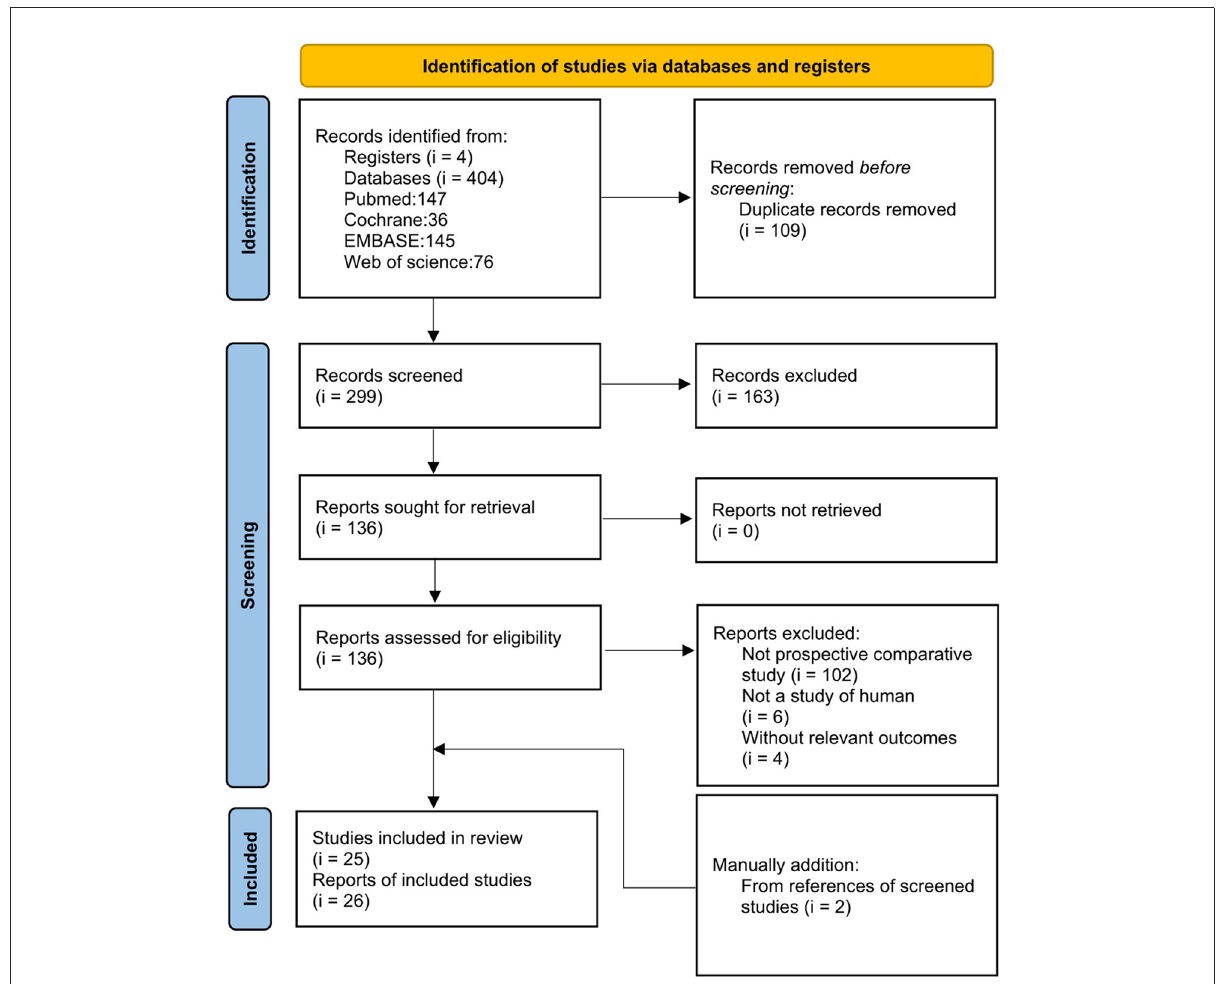
FIGURE1 Flowchart of evidence selection for the synthesis of the usage of α 1-antagonists in patients with lower urinary tract syndrome or benign prostatic